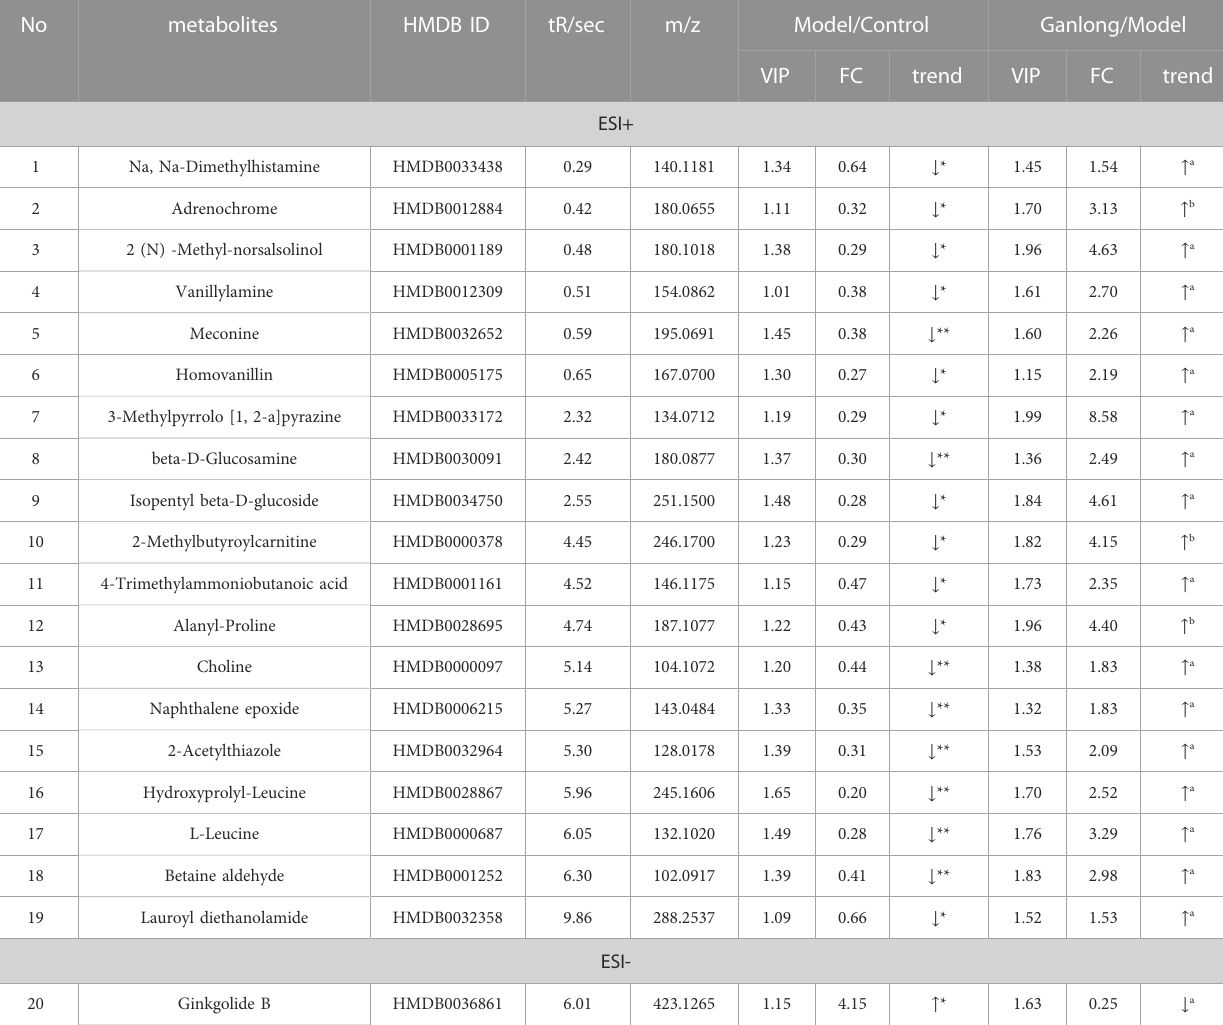
TABLE 5 Summary of the differential metabolites identi fi ed in the urine of three